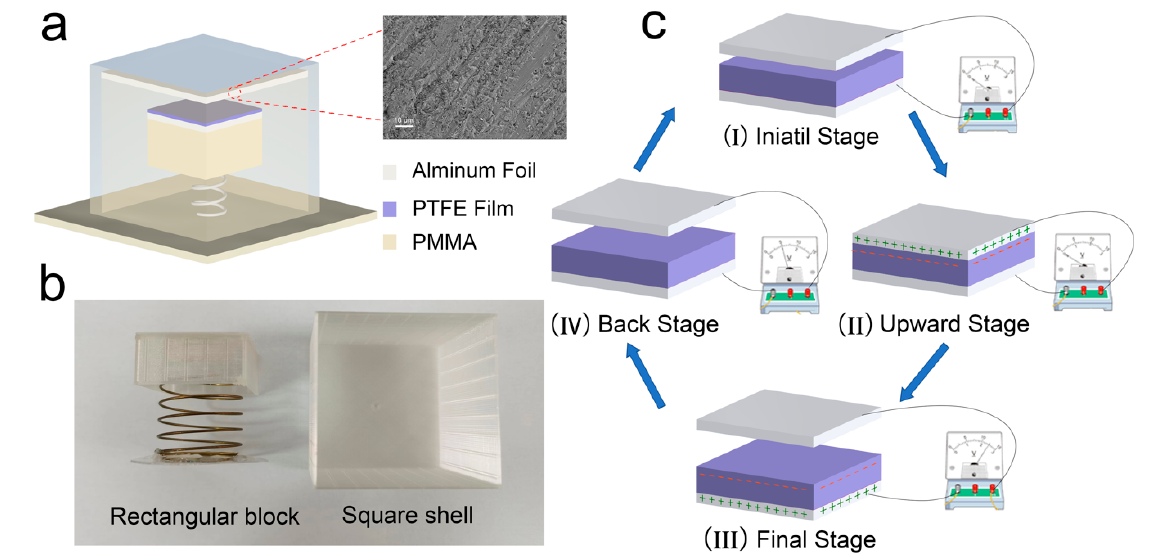
Figure 1. ( a ) Schematic illustration of the S-TENG device. ( b ) Digital photographs of the two components of S-TENG. ( c ) Schematic diagram of the working principles of the developed S-TENG.